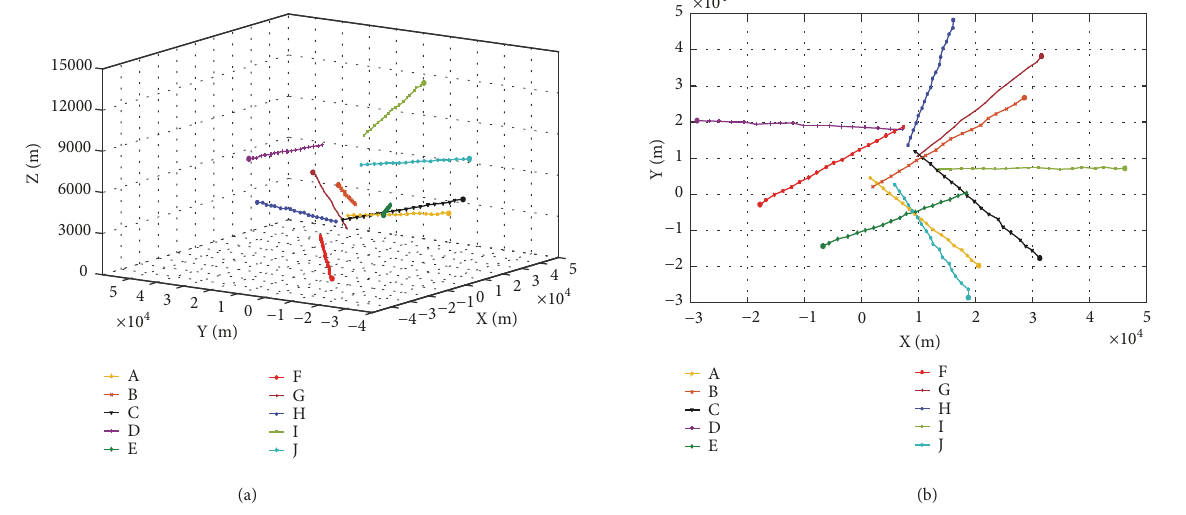
Figure 3: 10 aircraft’s flight trajectories: (a) 3D and (b) X-Y